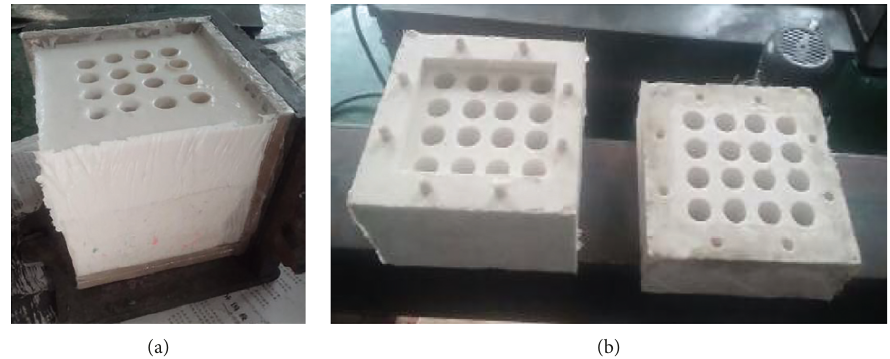
Figure 7: Fabrication of the silicone mold. (a) Silicone top mold casting. (b) The upper and lower mold.